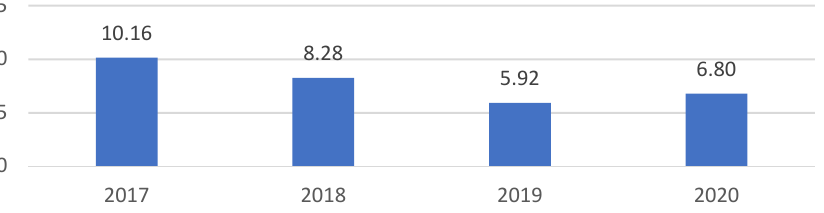
Figure 6. NPM (median) of biogas plants in 2017–2020 (%). Note: our calculations based on the biogas plant’s financial statements.